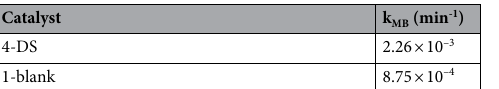
Table 2. Degradation rate constants for MB photo-degradation in the presence of the 4-DS and the 1-blank samples.